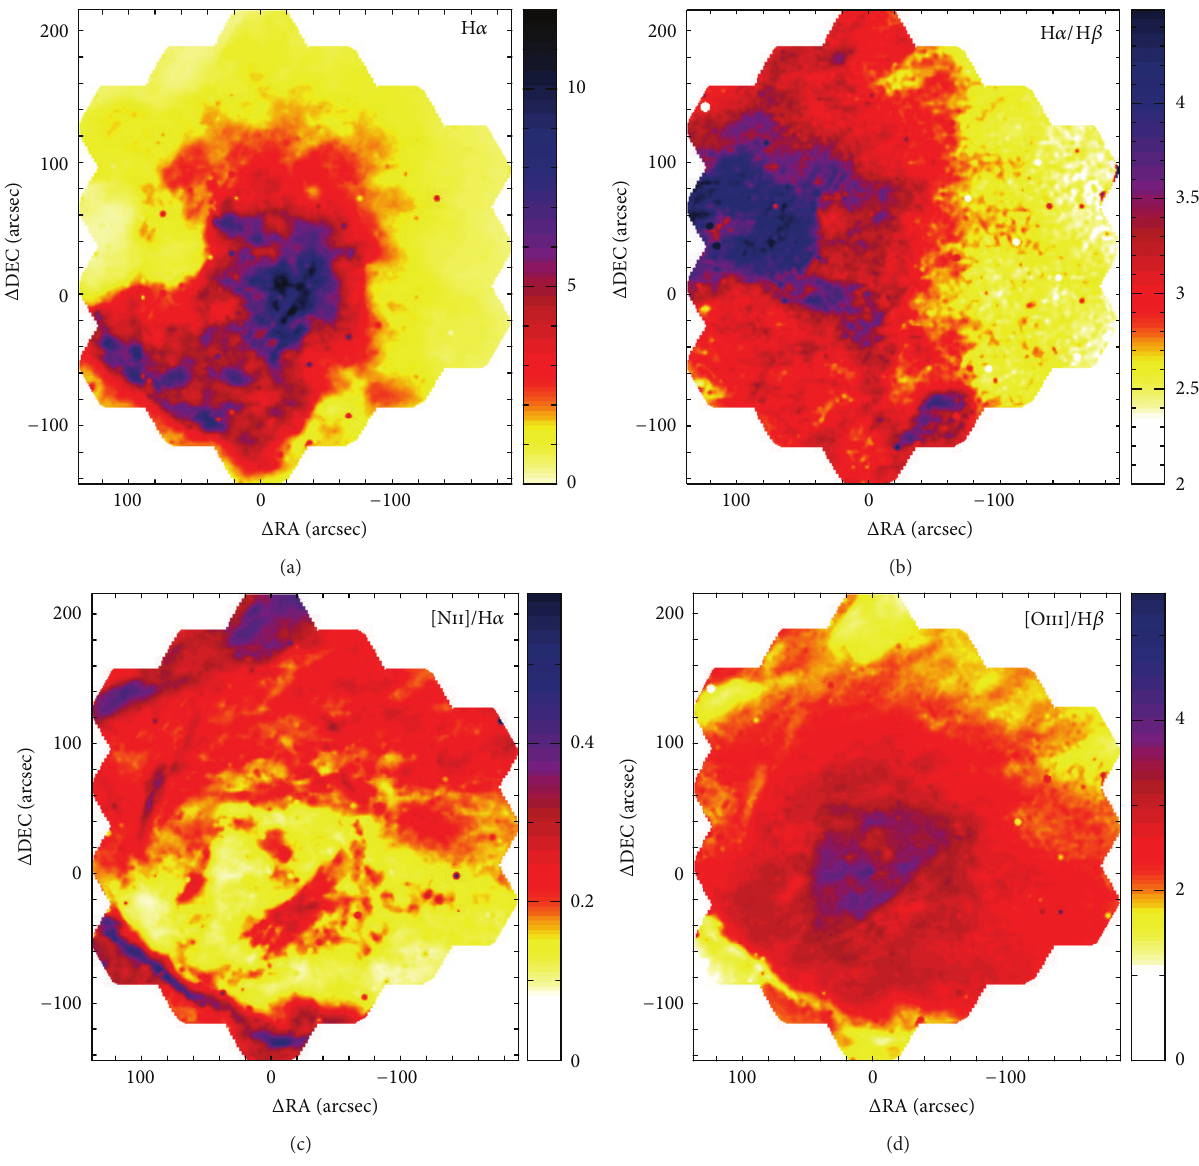
Figure 1: (a) Observed H 𝛼 Line intensity map in units of 10 −12 ergs −1 scm 2 arcsec −2 obtained by fitting a single Gaussian function to the H 𝛼 emission line for each single spectrum in the dataset. The intensity map is then reconstructed by interpolating the recovered flux at the location of each spectrum, as described in the text. (b) Observed H 𝛼 /H 𝛽 line ratio map. ((c) and (d)) Classical diagnostic line ratio maps. (c) [Nii] 𝜆 6583/H 𝛼 line ratio map. (d) [Oiii] 𝜆 5007/H 𝛽 line ratio